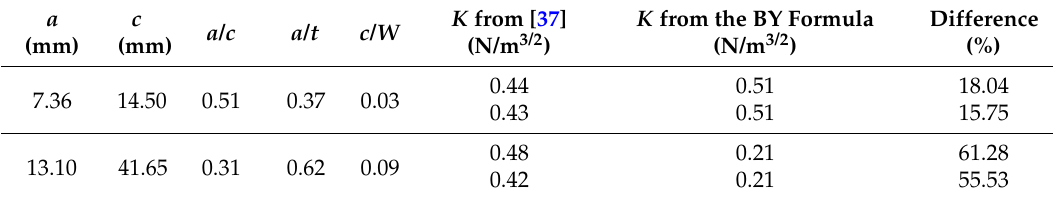
Table 1. The Baik-Yamada formula vs. the photo-elastic experimental